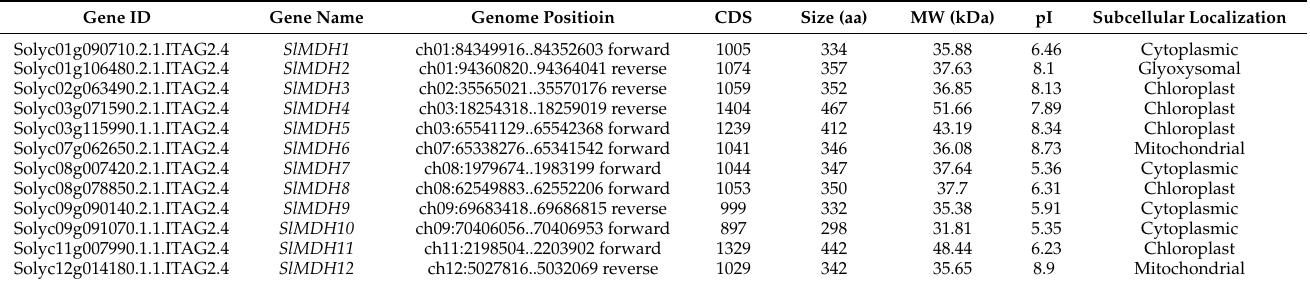
Table 1. 12 MDH genes retrieved sequences from the genome of S. lycopersicum